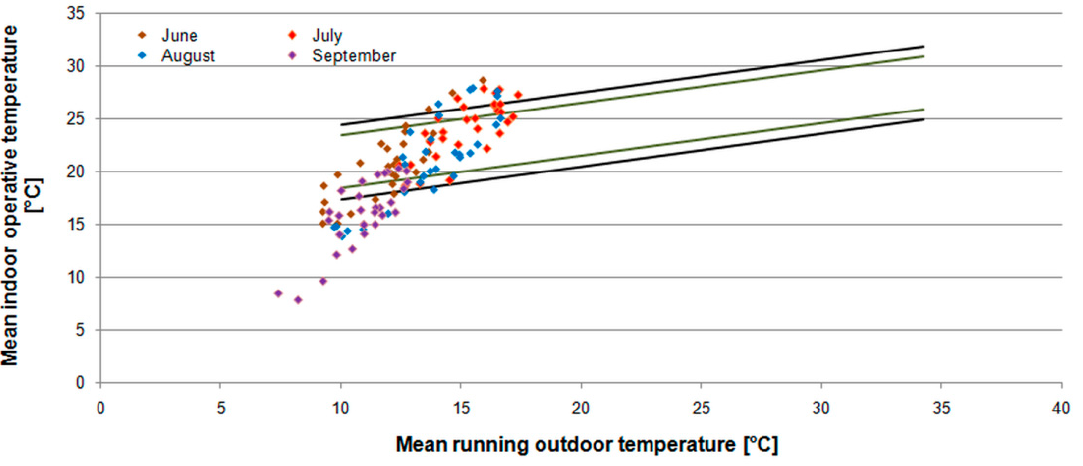
Figure 8. Comfort zone of EN 15251 and daily operative temperature in analyzed months. Category I: green lines, Category II: black